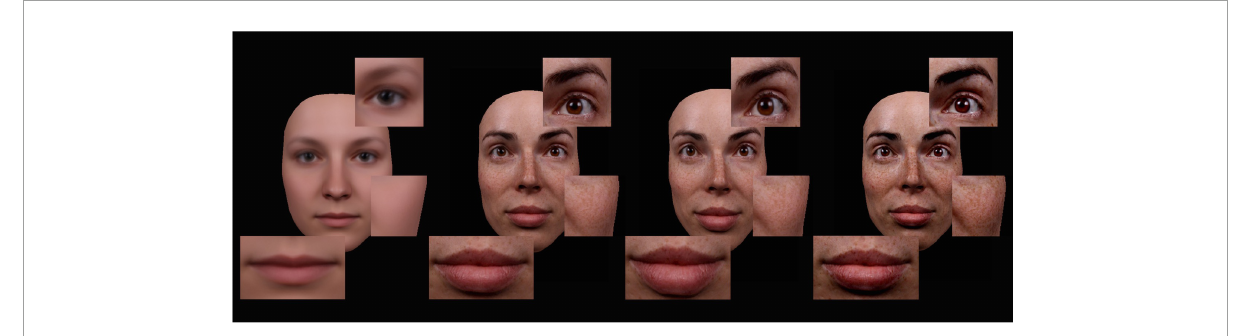
FIGURE1 Examples for parameter-specific facial caricatures. From left to right : (1) An average female face, (2) a veridical individual face, (3) a shape caricature (50%) of that face (with unchanged texture information), and (4) a texture caricature (50%) of that face. Figure adapted from Limbach et al. (2022), with permission, Rightslink Ref. No.